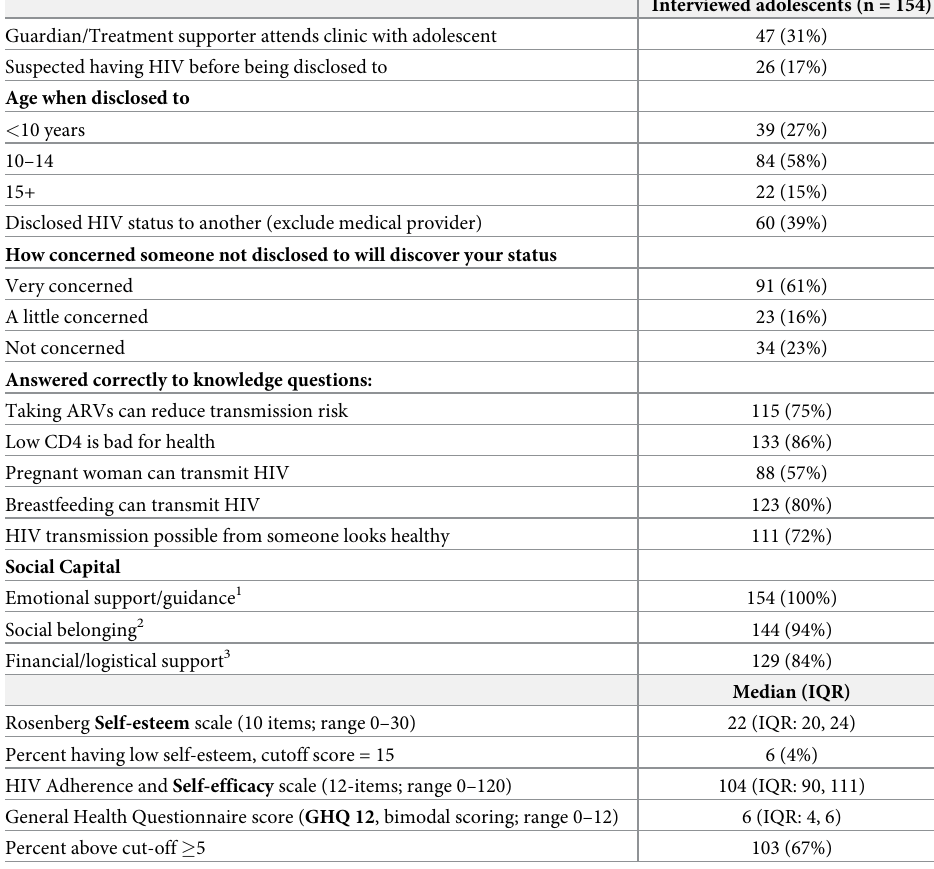
Table 2. Characteristics of HIV care-seeking, disclosure, knowledge and measures of well-being assessed among the subset of adolescents enrolled and interviewed (n =